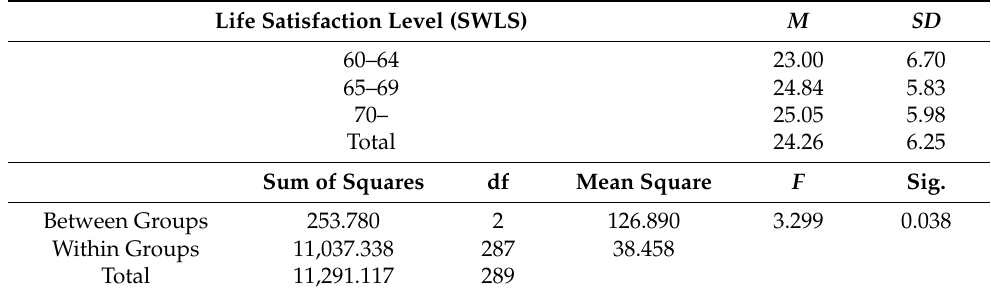
Table 2. Descriptive statistics and one-way ANOVA for life satisfaction levels on the SWLS by age group.